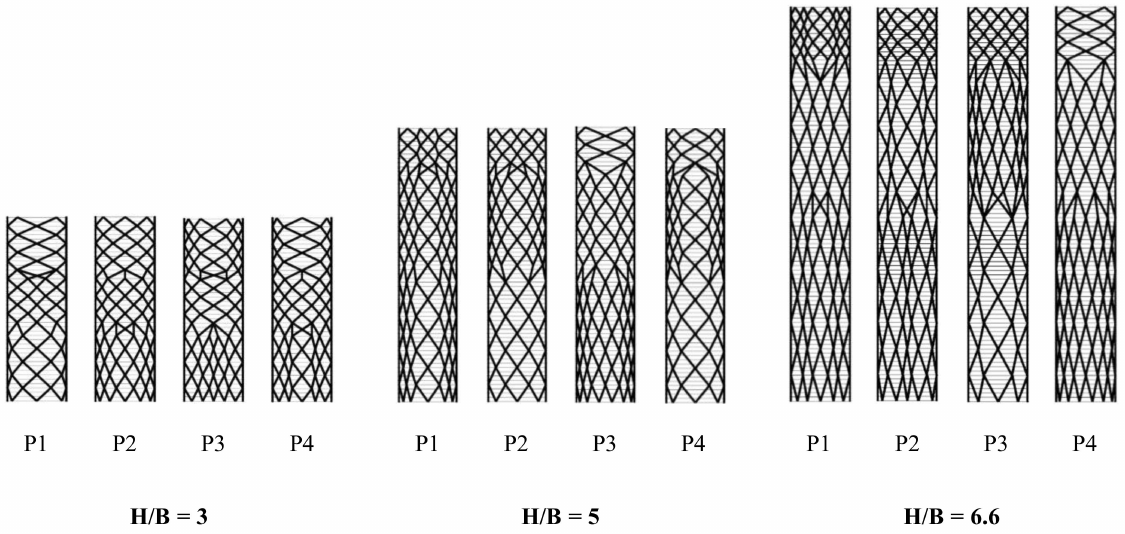
Figure 12. Examples of patterns obtained from the generative design workflow. The solutions selected at the end of the generative and optimisation process and indicated as TO patterns are the ones characterised by the minimum diagrid weight for each slenderness value and are depicted in Figure 13, together with the regular diagrids (RE) and the PDI patterns, adopted as benchmark structures in the comparisons.